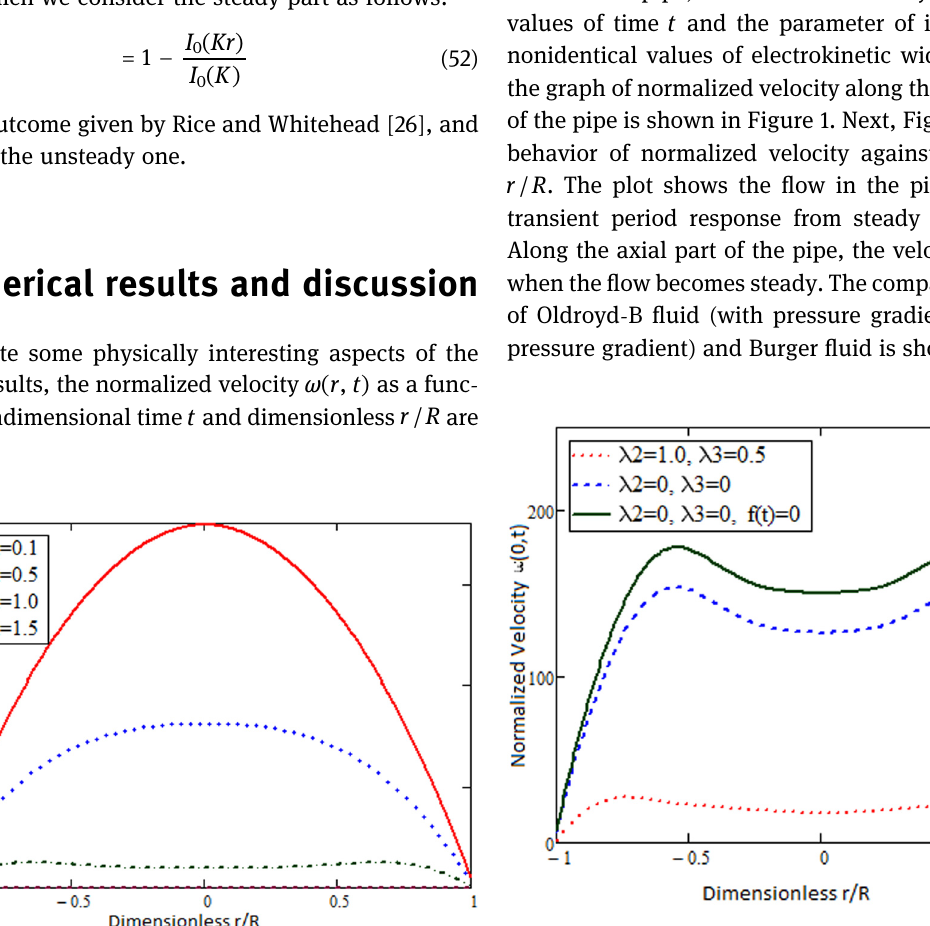
Figure 2: In the pipe behavior of fl ow when